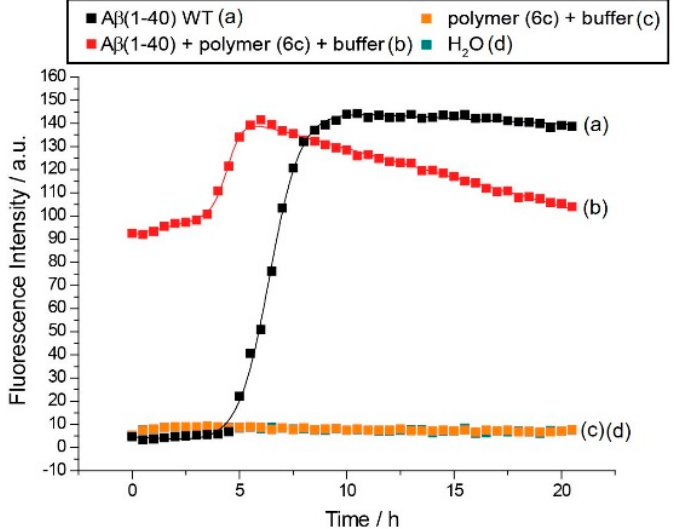
Figure 4. Thioflavin T fluorescence intensity of the A β 40 /polymer ( 6c ) mixture ( b ) compared to WT A β 40 ( a ) and the pure polymer ( 6c ) ( c ) in buffer solution, as well as pure water ( d ). Both the characteristic and lag time are shortened for the peptide/polymer mixture compared to WT A β 40 fibrillation kinetics. The characteristic time, which reports the time at which half the fluorescence maximum is reached, decreases from 6.4 down to 4.5 h, and the lag time is reduced from 4.9 down to 3.7 h. The higher initial thioflavin T (ThT) fluorescence of A β 40 in the presence of 6c ( b ) could be related to an initial nucleation that was too fast to be recorded in our experimental setup. The observed decrease of the fluorescence after t = 5 h ( b ) often is the result of the precipitation of the sample.